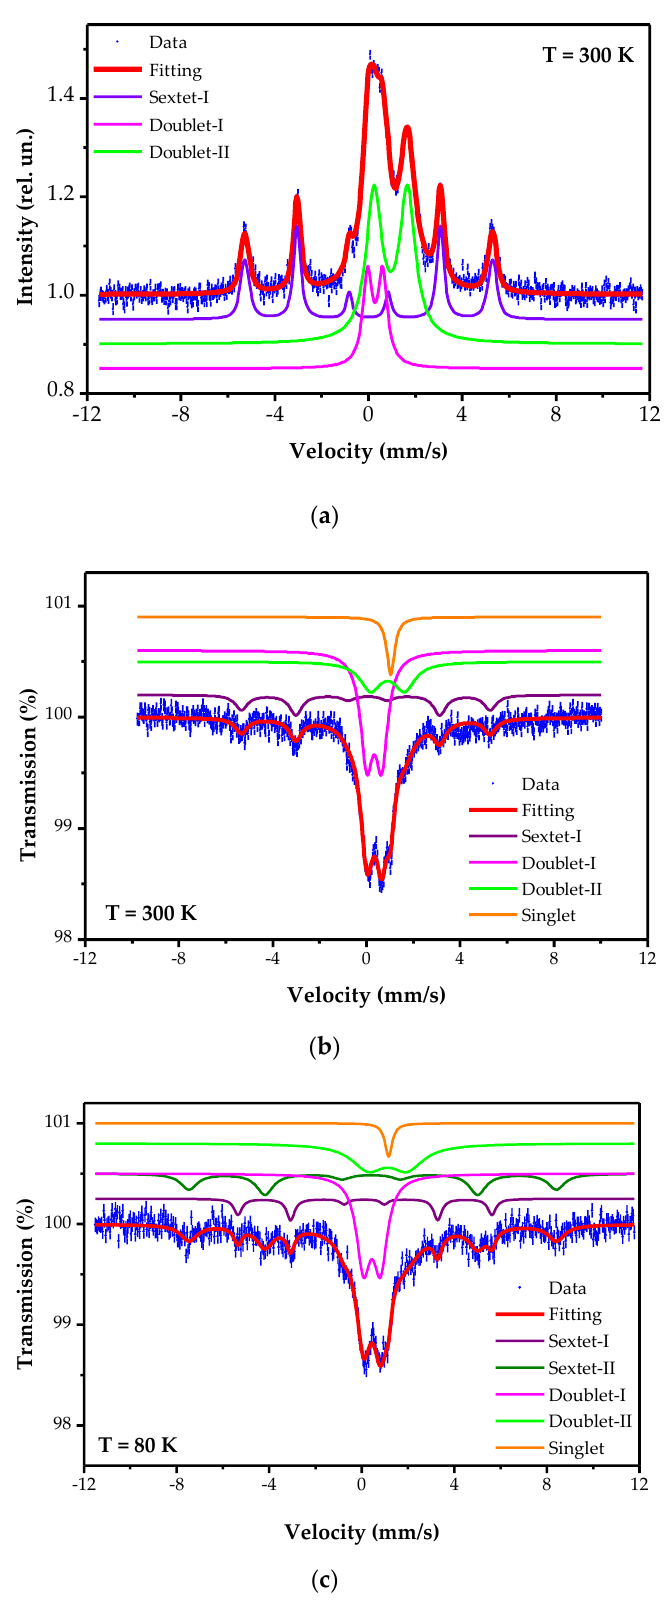
Figure 2. Mössbauer spectra of Fe-ion implanted MgO: ( a ) CEMS at RT; ( b ) and ( c ) in transmission geometry at RT and 80 K, respectively.